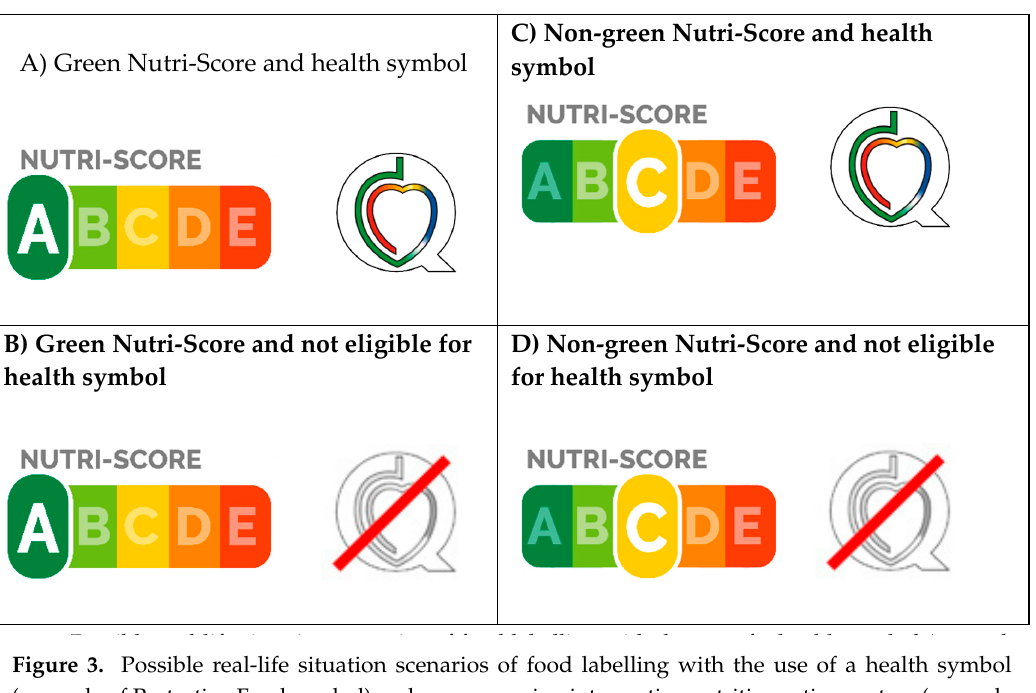
Figure 3. Possible real-life situation scenarios of food labelling with the use of a health symbol (example of Protective Food symbol) and accompanying interpretive nutrition rating system (example of Nutri-Score): ( A ) Green Nutri-Score and health symbol; ( B ) Green Nutri-Score and not eligible for health symbol; ( C ) Non-green Nutri-Score and health symbol; and ( D ) Non-green Nutri-Score and not eligible for health symbol.